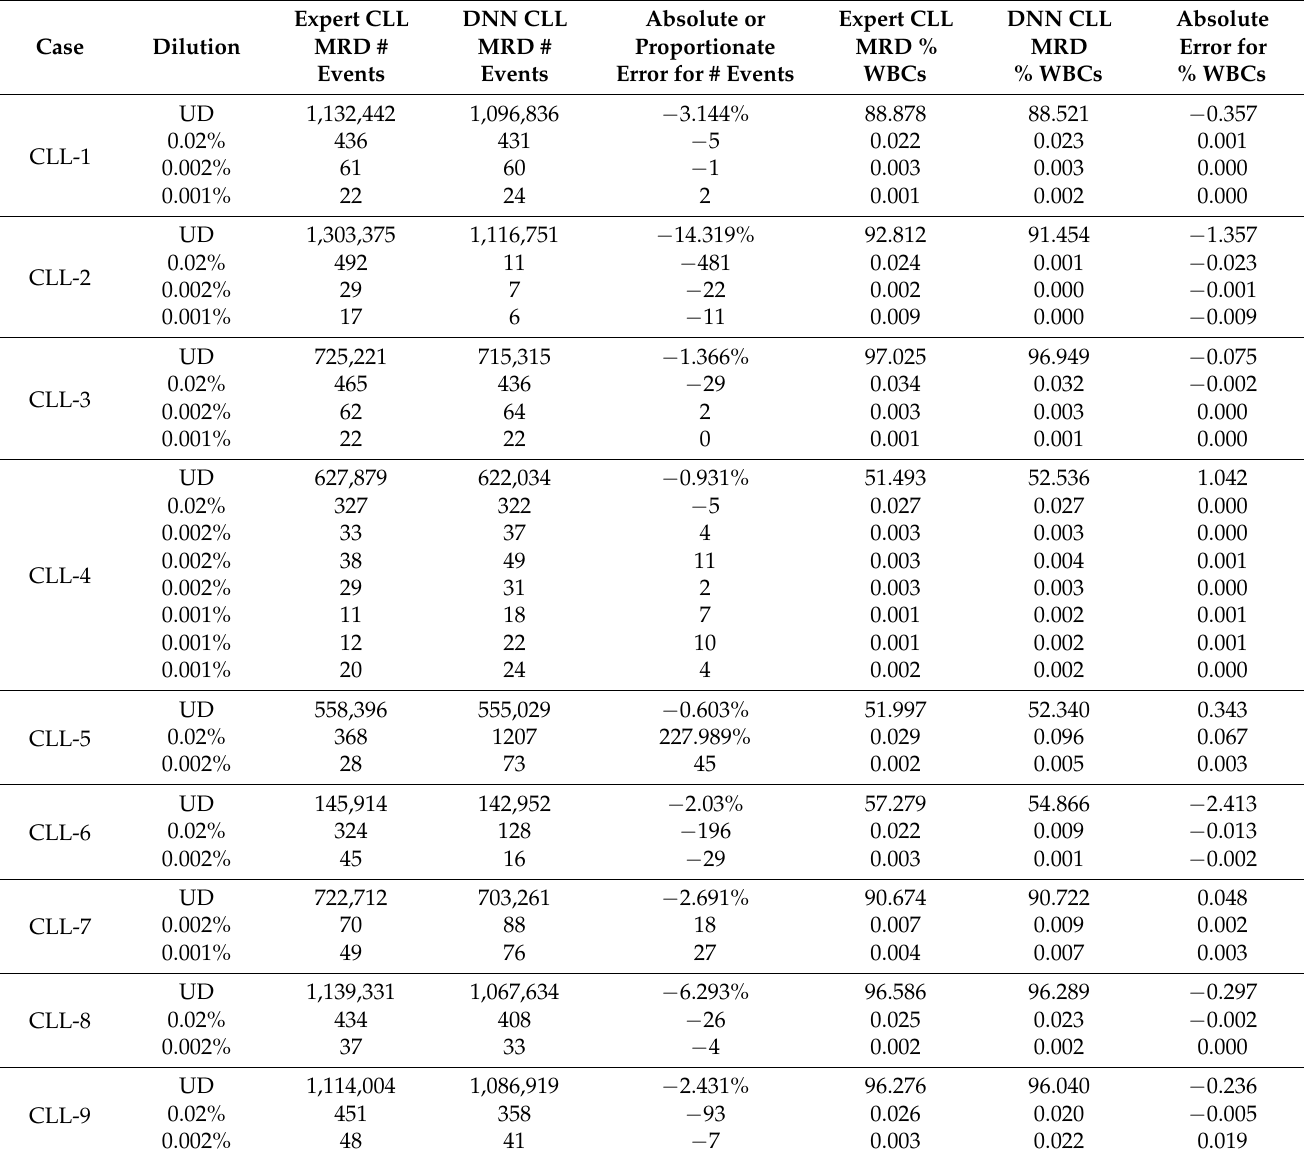
(Table 4). Overall, quantitative estimates of CLL MRD were similar between the hybrid DNN predictions and the “ground truth” case counts. Of note, the hybrid DNN approach, and the L-DNN in particular, failed to detect abnormal events in serial dilution samples of one of the nine CLL MRD-positive cases when the MRD level was low (case CLL-2). L-DNN classified all of the serial dilution samples for this case as CLL MRD-negative; further review identified that the abnormal events in this case (CLL-2 in Table 4) displayed an aberrant phenotype with brighter expression of CD20, which is an unusual immunophe- notype for CLL. Although these events were not classified as abnormal CLL cells by the L-DNN, they were detected by the F-DNN. Table 4. CLL MRD comparison between expert-gated (ground truth) and DNN-gated from serially di- luted samples (n = 9 unique cases). The absolute error (delta), for cases with CLL MRD events < 1000 and the proportionate error (% error), for cases with CLL MRD events ≥ 1000, for the total abnormal clonal cell population inference per unknown sample versus the “ground truth” population was determined using the proposed workflow described in Figure 3. For the CLL MRD % WBCs, the absolute difference is